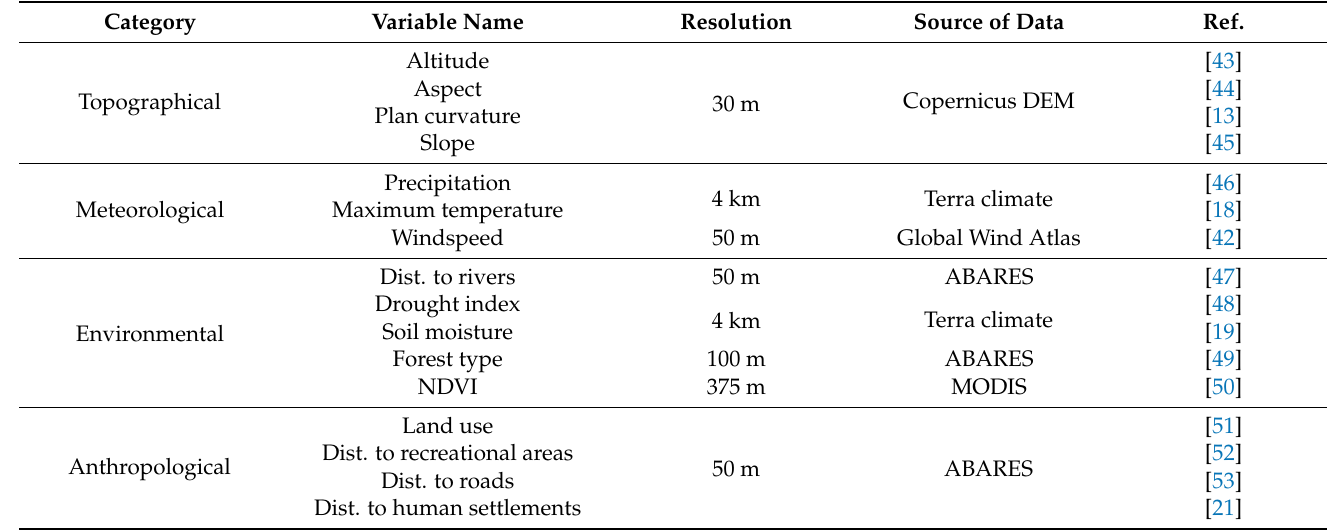
Table 2. Information on wildfire driving